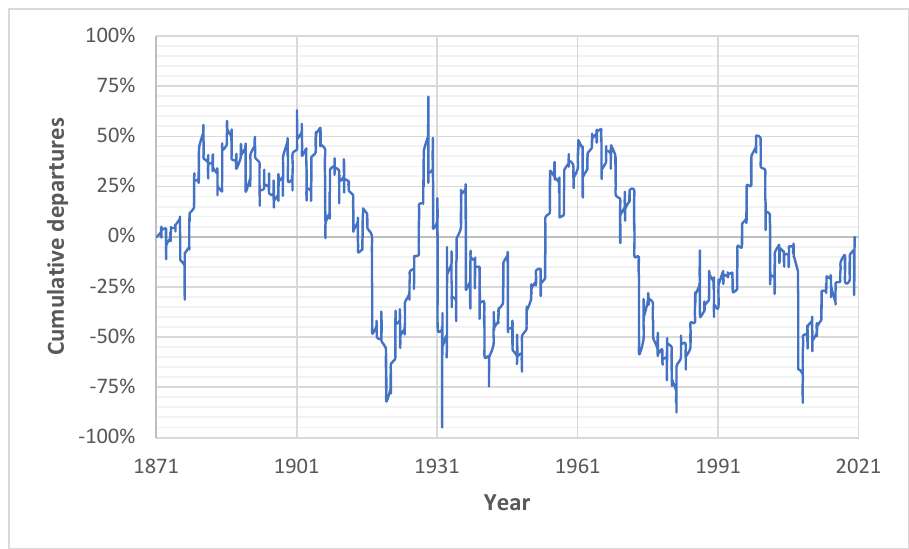
Figure 4. Monthly real rates of logarithmic return. Cumulative departures from the mean.